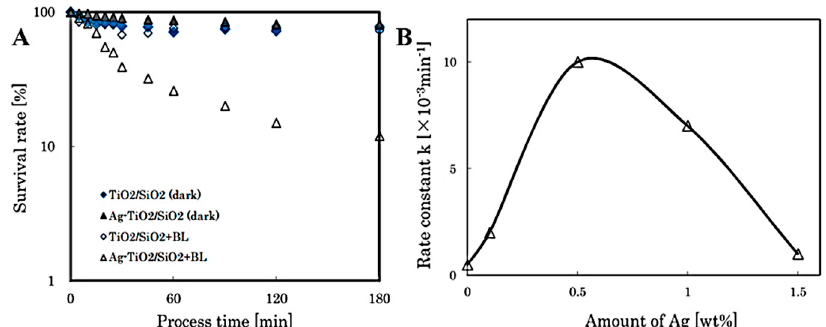
Figure 15. ( A ) Survival rate of sporulating Bacillus subtilis against process time using TiO 2 / SiO 2 and Ag-doped TiO 2 / SiO 2 (BL; under ultraviolet irradiation, dark; without UV irradiation). ( B ) Relationship between Ag amount and rate constant [368].